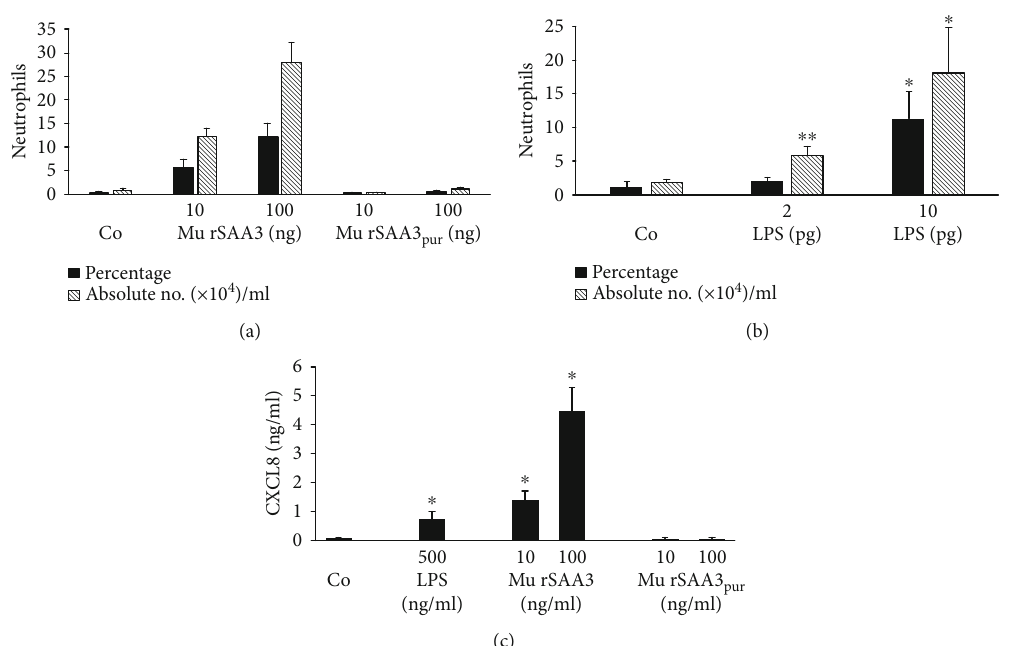
Figure 8: In contrast to impure mu rSAA3, RP-HPLC-puri fi ed mu rSAA3 (mu rSAA3 Female NMRI mice were injected i.p. with 100 μ l of PBS (Co), mu rSAA3 (10 or 100ng) or RP-HPLC-puri fi ed mu rSAA3 100ng; 3-5 mice per group). After 2 h, mice were sacri fi ced and peritoneal lavages were performed. Total cell counts in peritoneal